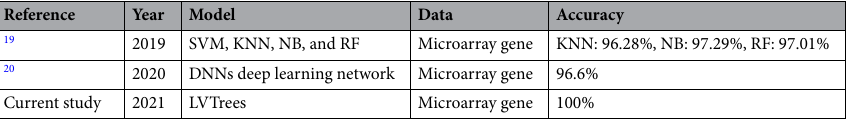
Table 19. Comparison with previous